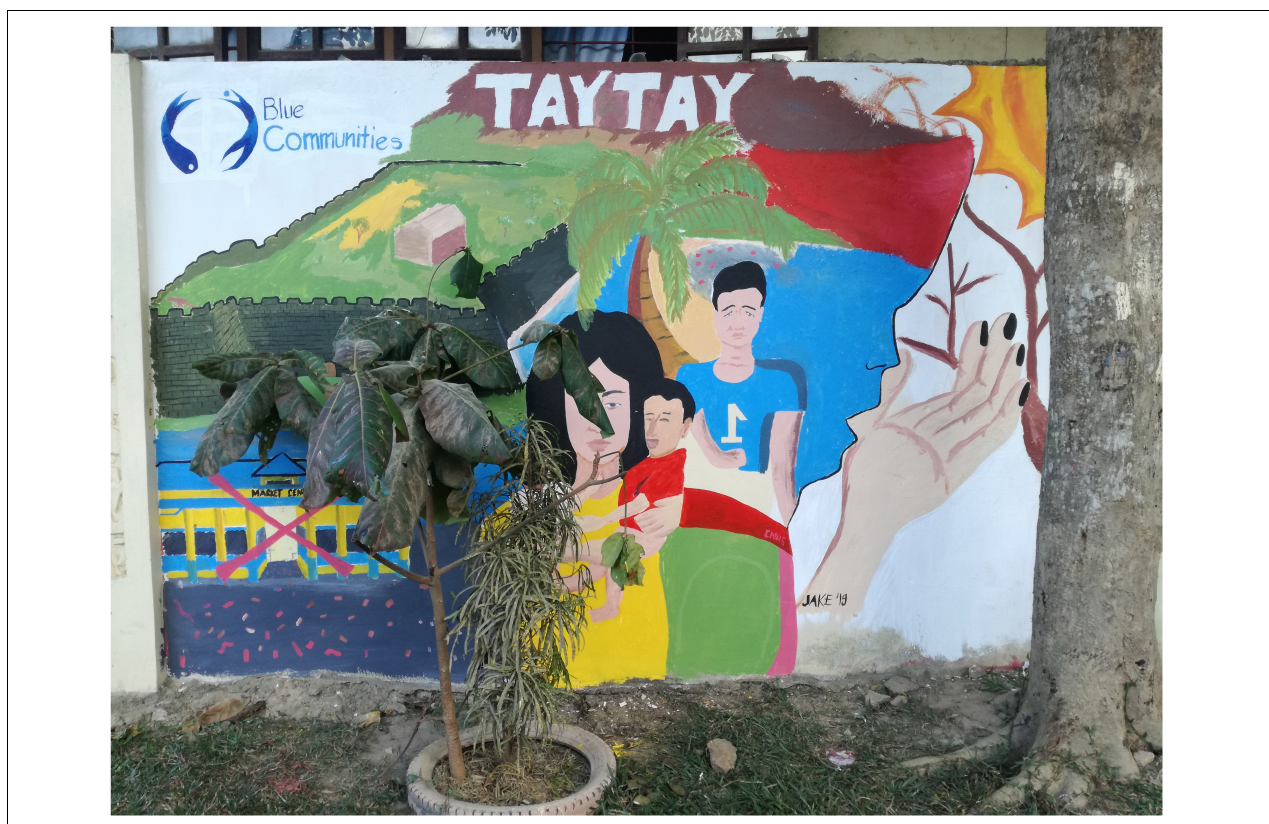
FIGURE 3 | Example of the Worst Case Scenario drawing, converted into a mural painting in Taytay town after the study was